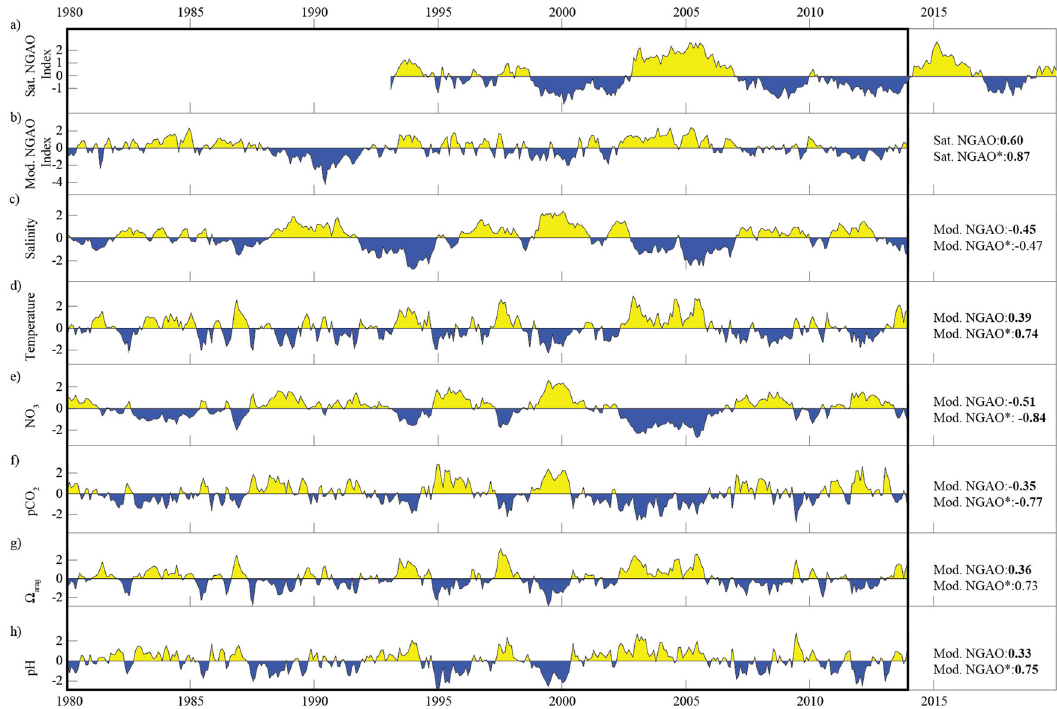
Fig. 2 Empirical orthogonal function (EOF) temporal patterns. Time series of the a Northern Gulf of Alaska Oscillation (NGAO) Index of satellite observed sea surface height (SSH) anomalies, b NGAO of modeled SSH anomalies, and the normalized principal components associated with the fi rst Empirical Orthogonal Function (EOF) mode of c salinity, d temperature, e NO 3 , f pCO 2 , g saturation state for aragonite ( Ω arag ), and h pH. The EOFs were computed based on the illustrated spatial domain in Fig. 1. The amount of explained variance of each EOF is given in the lower-left corner of each map in Fig. 1. The EOFs were applied to monthly model output after fi rst removing a long-term temporal trend using a quadratic function and second deseasonalizing the data. The Pearson correlation coef fi cients between the NGAO of the modeled SSH anomalies and each variable are given on the right side of the time-series of each variable (in bold when p < 0.05). The correlation coef fi cients designated with a star were based on low pass fi ltered data (6 years). Autocorrelation and the effective degrees of freedom were accounted for in this statistical analysis 54 . The black frame illustrates the time period of the ROMS-Cobalt hindcast simulation (1980 −